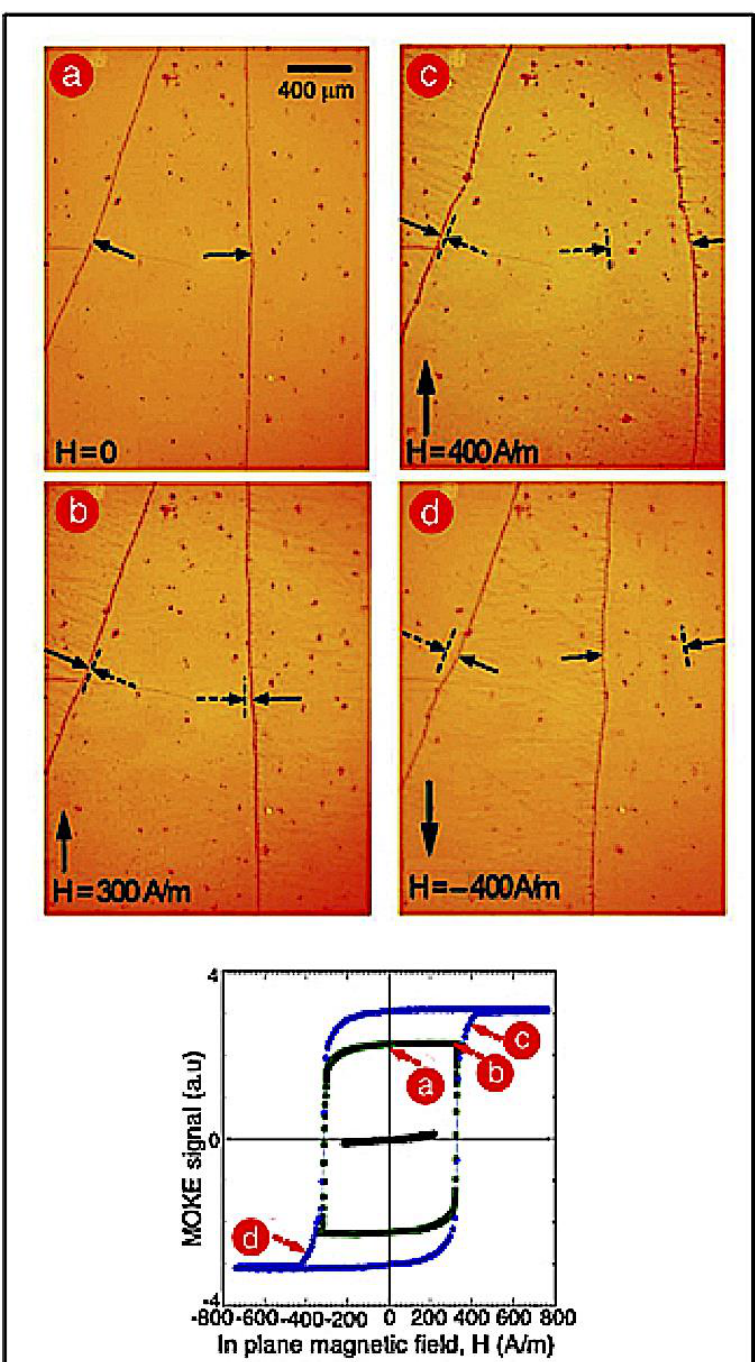
Figure 7. Movement of magnetic walls in 33 nm thick film when DC magnetic field was applied (large vertical arrows): ( a ) H appl. = 0, ( b ) H appl. = +300 A m −1 , ( c ) H appl. = +400 A m −1 , and ( d ) H appl. = −400 A m −1 , demonstrating applied field direction. Small arrows in each image indicate position of magnetic wall before (dashed) and after (solid) application of magnetic field. Bottom : MOKE hysteresis loops at different applied field strengths indicating magnetic state in which images were obtained. In summary, different types of charged magnetic domain walls were observed in the Fe films depending on their thickness. (1) At thickness lower than ≈ 30 nm, the charged walls had Néel-type cores and exhibited irregular shapes.